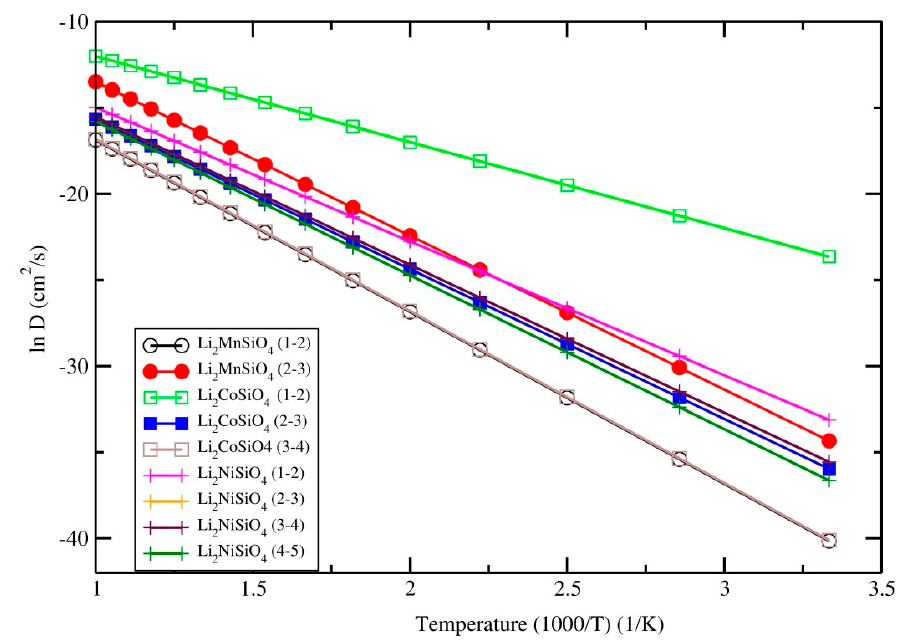
Figure 12. Natural logarithm of the diffusion coefficient against 1/T for different possible path ways in Li 2 MnSiO 4 ( Pmn 2 1 ), Li 2 CoSiO 4 ( Pbn 2 1 ), and Li 2 NiSiO 4 ( P 2 1 ) obtained from NEB method. For the clarity of the figure only equilibrium structures natural logarithm of the diffusion coefficient against 1/T are shown in the figure.